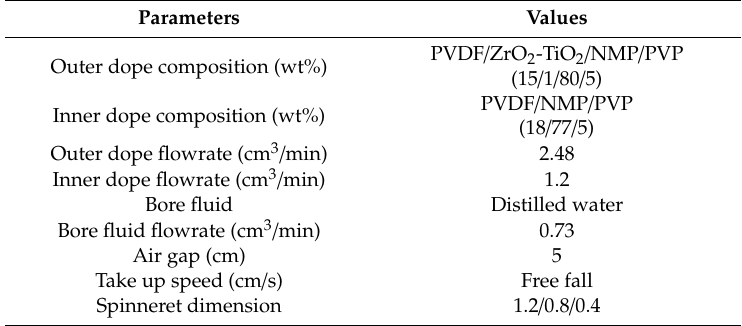
Figure 1. Schematic diagram of the dual-layer hollow fiber (DLHF) membrane structure with ZrO 2 -TiO 2 embedded polyvinylidene fluoride (PVDF) outer layer and PVDF inner layer. Table 1. Spinning conditions for PVDF / ZrO 2 -TiO 2 DLHF membrane